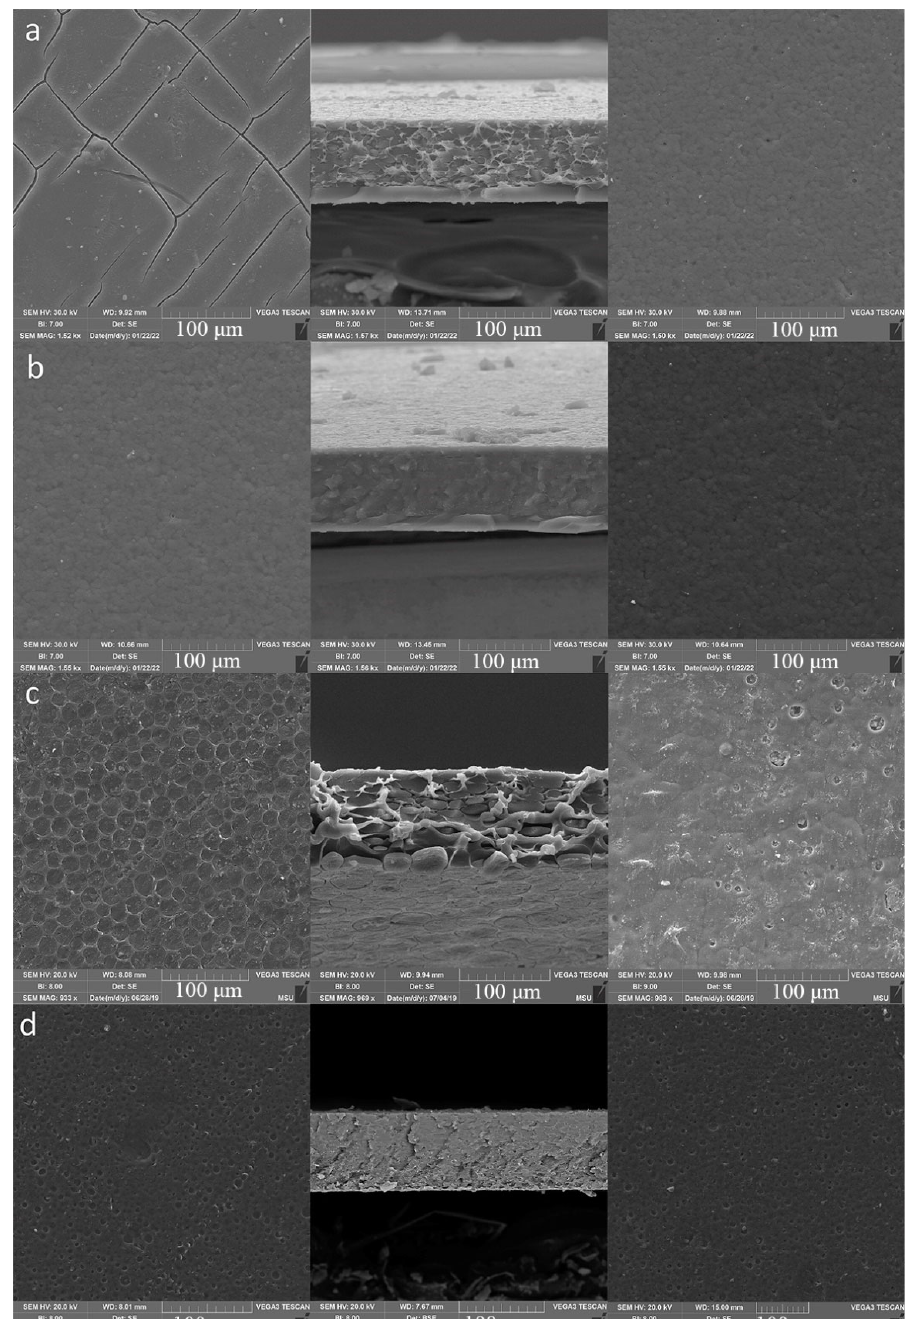
Figure 4. SEM images of bottom (left), top surfaces (right) and cross ‐ section (middle) of PVDF blend membranes based on SAPPhNB ‐ Im ( a ), SAPPhNB ‐ MIm ( b ), SHPPhNB ‐ Im ( c ), SHPPhNB ‐ MIm ( d